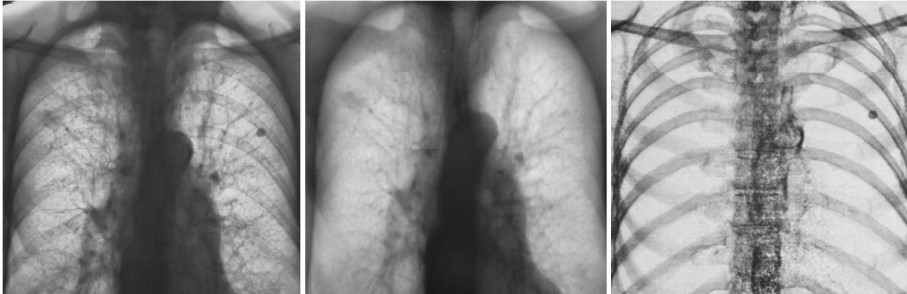
Figure 7. Images obtained on a prototype dual energy digital chest radiographic unit at the University of Alabama Birmingham circa 1985 with a single exposure of a patient with lesions present in both sides of the lung in the conventional digital image ( left ); Soft tissue ( center ) and bone ( right ) images of the patient. The nodule in the lung left side is calcified and benign. The nodule on right side is present in the soft tissue image and not in the bone image, was not calcified and was cancer